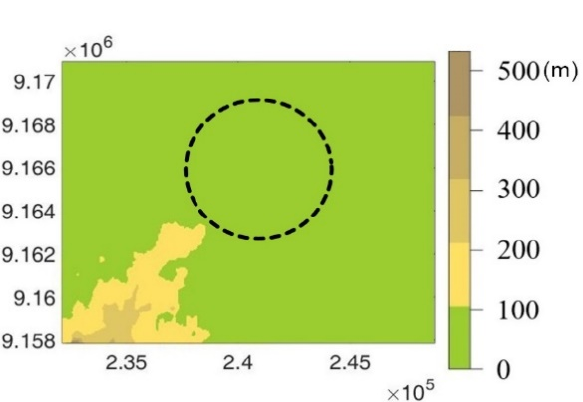
Figure A2. Terrain elevation of Wetar Island; the selected site is circled.